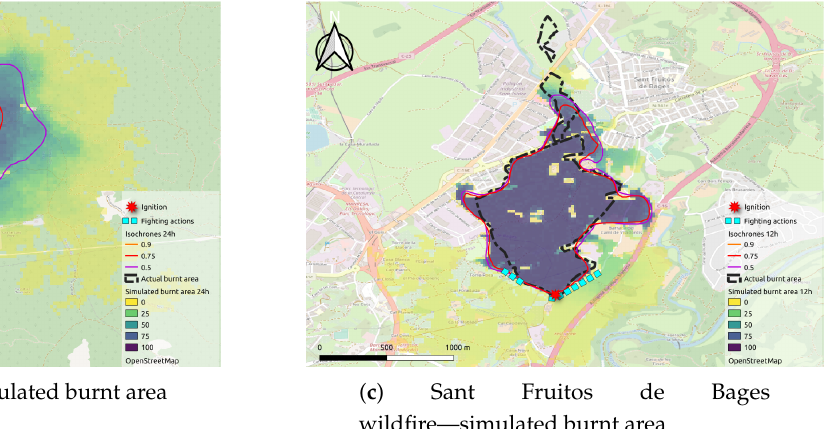
Figure 10. Comparison between the actual burnt areas and the simulated ones for the Catalan wildfires. The three images ( a – c ) show the actual burnt areas (black dash-dot lines), the ignitions (red stars), the implemented fighting actions (light blue dashed lines), the simulated burnt areas with their color scale, and the isochrones (colored lines) produced at the end of the simulations, which represent the burnt areas with probability higher than 50%, 75%, and